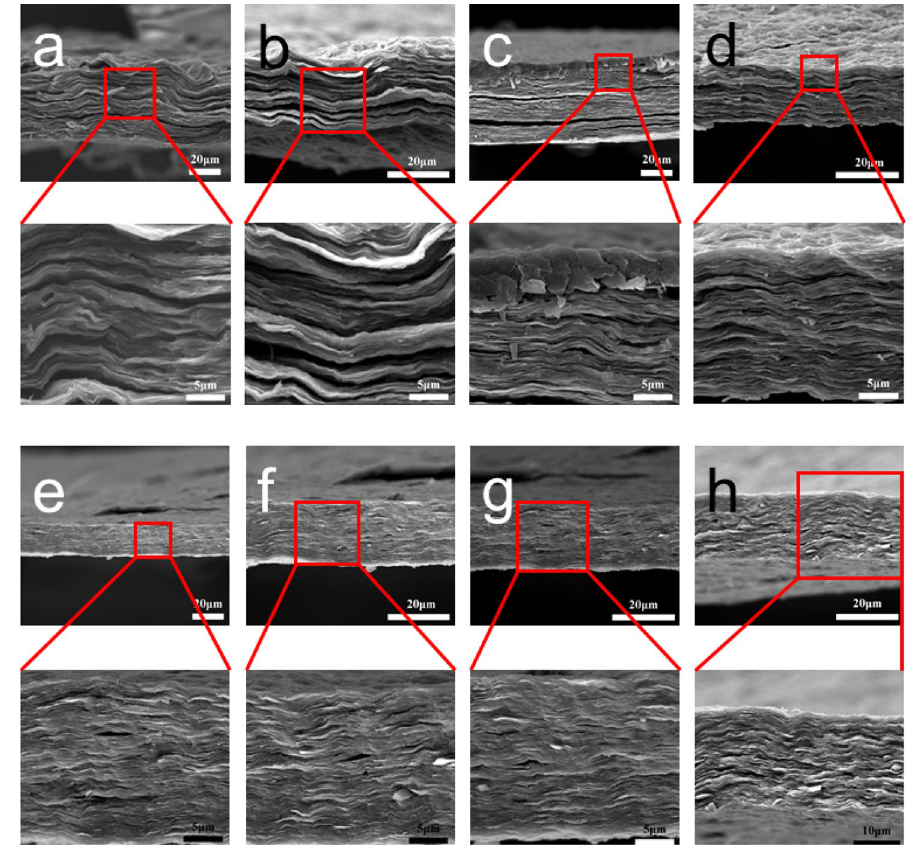
Figure 2. Fracture morphologies of ( a ) P-GP-1, ( b ) P-GP-2, ( c ) P-GP-3, ( d ) P-CP-4, ( e ) P-GCP-1, ( f ) P-GCP-2, ( g ) P-GCP-3, and ( h ) P-GCP-4 artificial nacres.